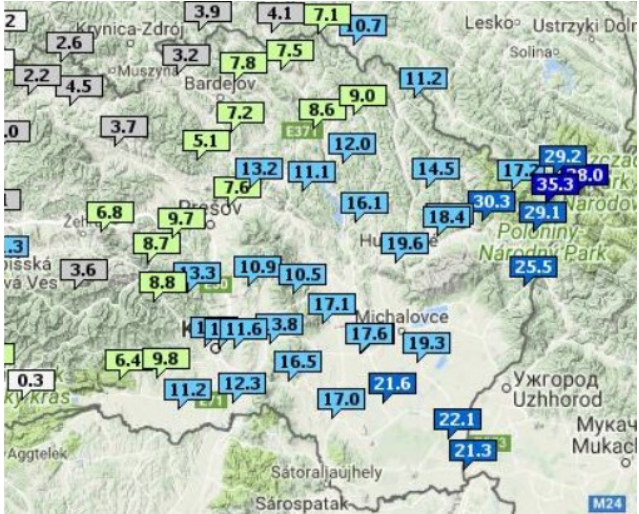
Figure 2. Map of mm/hr precipitation totals as of 16.12.2017 in the Bodrog basin. On this map, it is possible to see the achieved values of total precipitation at the level of up to 38.0 mm per hour [55]. Table 1. The table of culminating water levels and flows in selected flow stations in the temporal interval from November 2017 to March 2018. This table also shows data on the maximum water level and information about the N-year and the declared levels of flood activity [55,56].